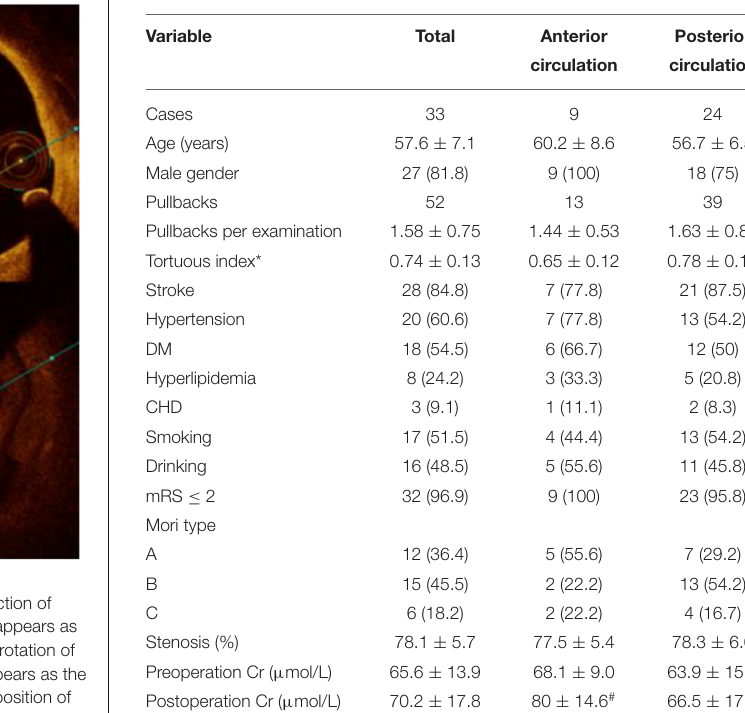
TABLE 1 | Baseline clinical and procedural